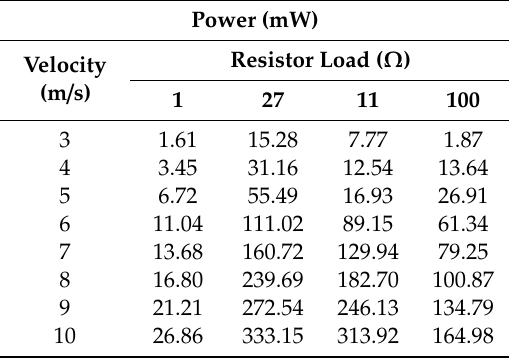
Table 12. Measured power at di ff erent conditions with the three-phase generator.